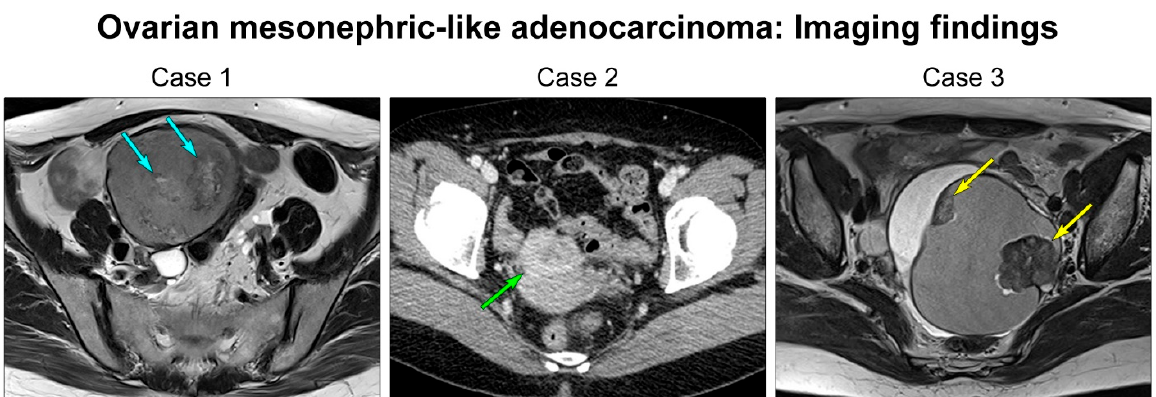
Figure 1. Imaging and gross findings of ovarian MLA. Pelvic magnetic resonance imaging (cases 1 and 3) and computed tomography (case 2) revealed cystic ovarian masses containing internal solid nodules (blue, green, and yellow arrows).